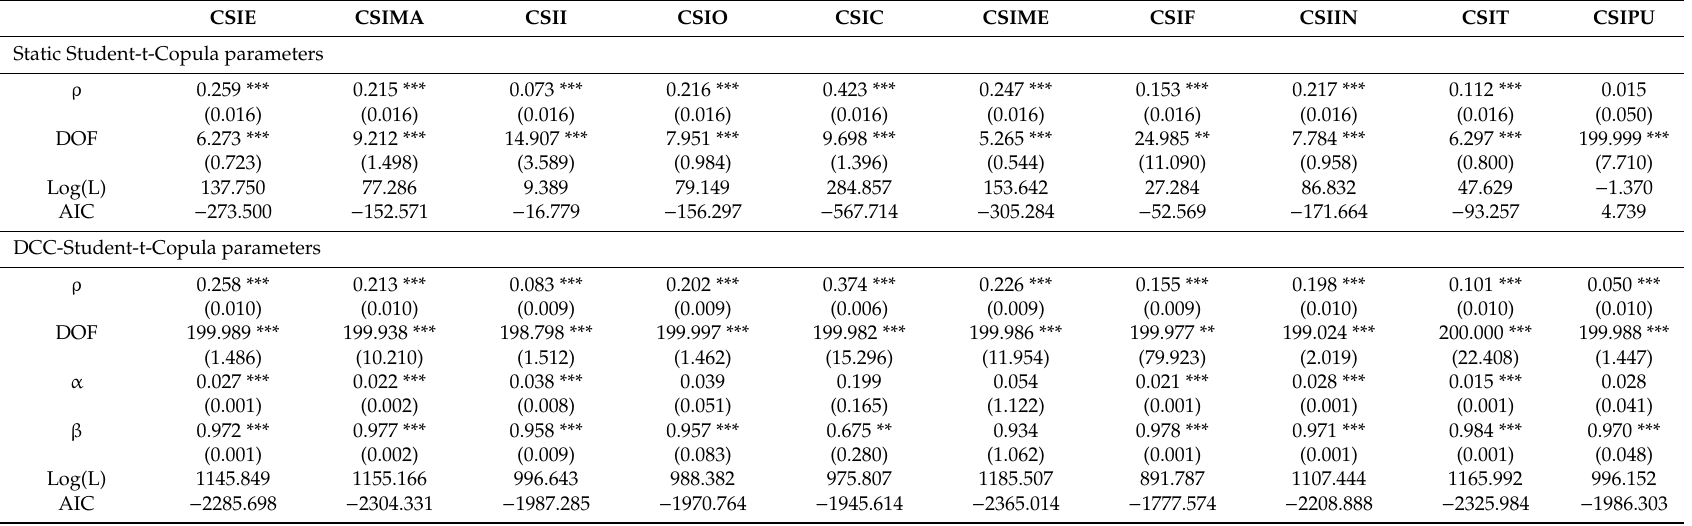
Table A4. Estimates of t-Copula for long-term trend between Brent spot price and the stock indexes of China Securities